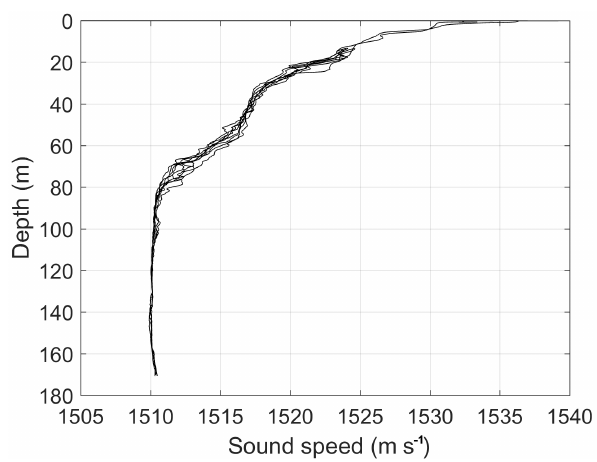
Figure 13. Sound speed profiles calculated using conductivity, tem- perature, and depth measurements made by the glider during the recording of the acoustic